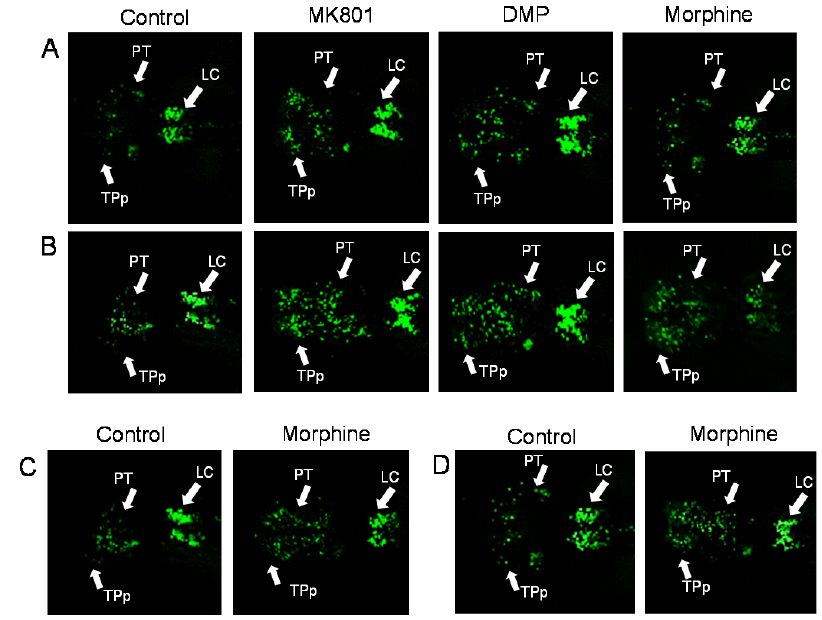
Figure 5. Distribution of dopaminergic neurons in Tg ( dat : EGFP) zebrafish. Representative confocal images showing the location of dopaminergic nuclei in the brains of the larval zebrafish following ( A ) short-term and ( B ) long-term exposure to MK801, DMP, and morphine, and after withdrawal of ( C ) short-term and ( D ) long-term treatment of morphine. Drug abbreviation: DMP, domperidone. Other abbreviations: LC, locus coeruleus; PT, posterior tuberculum; TPp, posterior tubercule.